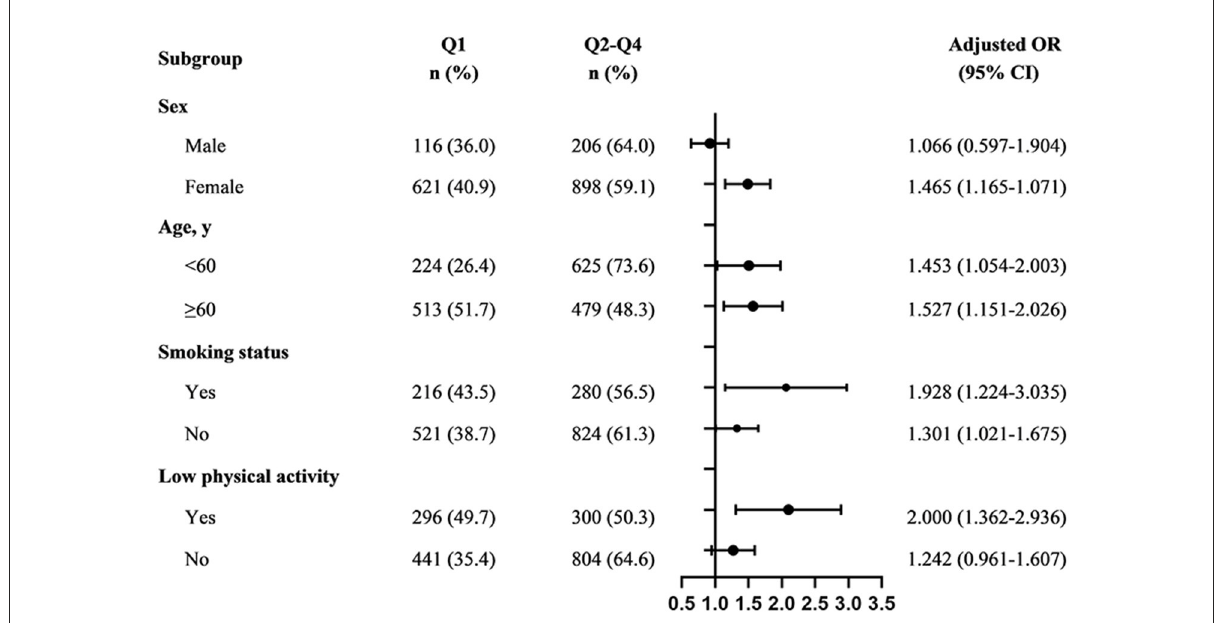
FIGURE3 Subgroup analyzes of the association between composite pulmonary function and MCI among participants with z -score for composite pulmonary function < 0.214. Q1: PF < − 0.6386; Q2–Q4: ≥ − 0.6386. Adjusted, if not stratified, for age, sex, BMI, marital status, ethnicity, education level, smoke exposure, alcohol consumption, physical activity, hypertension, diabetes, histories of CHD and COPD; MCI, mild cognitive impairment; ORs, odds ratio; CIs, confidence interval.